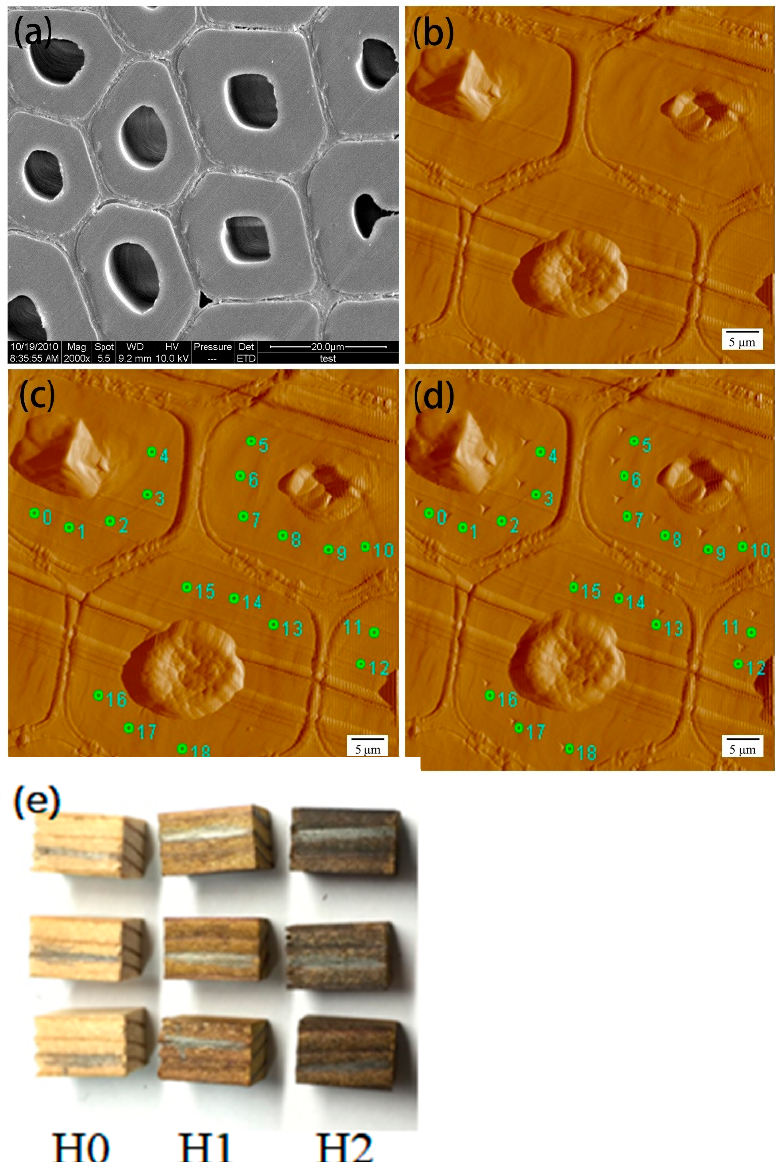
Figure 2. The image of SEM/SPM image before and after nanoindentation and the samples before and after heat treatment: ( a ) SEM image; ( b ) wood cell wall before indentation; ( c ) the marks of indentation; ( d ) after indentation; ( e ) wood samples before and after heat treatment. Based on the curves of indent depth versus time, the creep strain rate can be obtained. The creep strain rates of samples are strongly dependent on the stress. The creep data of wood cell wall can be obtained by nanoindentation test. The strain and creep compliance of wood cell wall can be calculated as